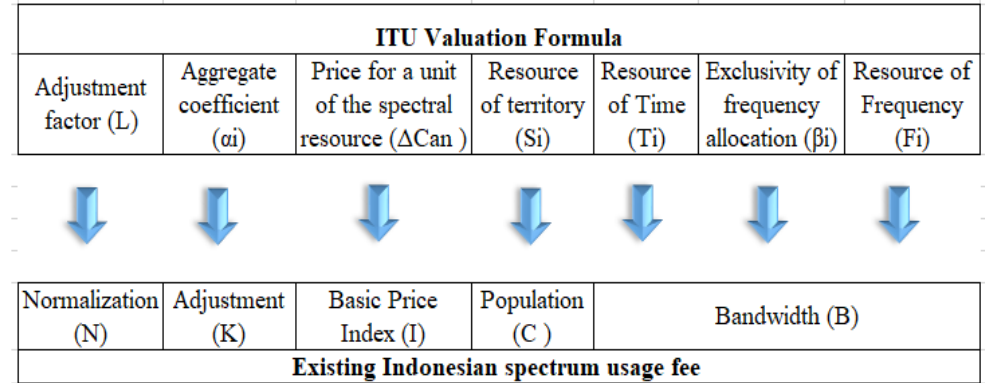
Figure 6. Spectrum valuation formula from ITU-R SM.2012-5 (06/2016), adapted from the current Indonesia spectrum usage fee.